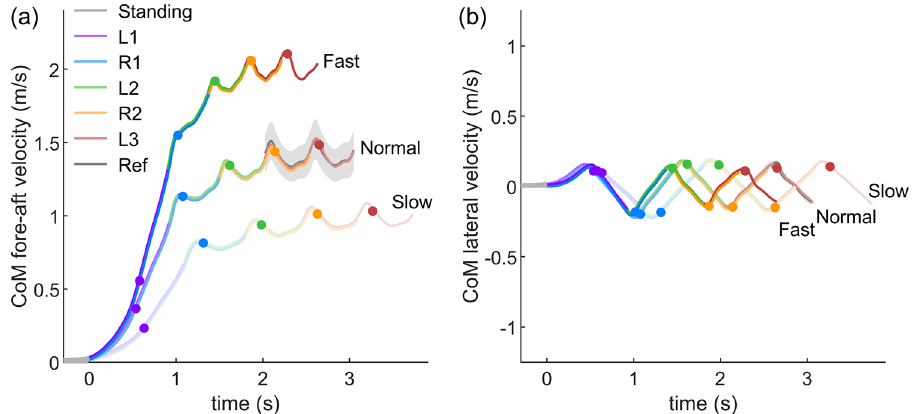
Figure 2. Mean CoM velocity over 23 subjects for the slow, normal and fast target velocity gait initiation. Ref denotes the regular overground walking at the self-selected preferred velocity. The light gray error band indicates the ± 1 standard deviation of Ref. The error band of each stride is not shown to keep the figure easy to read. Time 0 is defined as the start of gait initiation. Different colors denote different strides. The dots denote the take-off timing. ( a ) The CoM velocity in the fore-aft direction. Positive values indicate the forward direction. ( b ) The CoM velocity in the lateral direction. Positive values implies the CoM is moving towards the subject’s right- hand side (the trailing limb